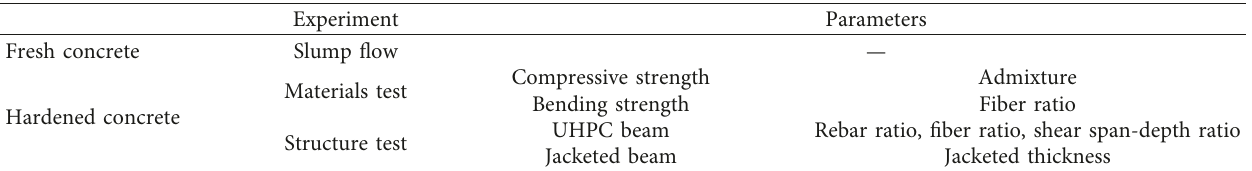
Table 2: Experimental